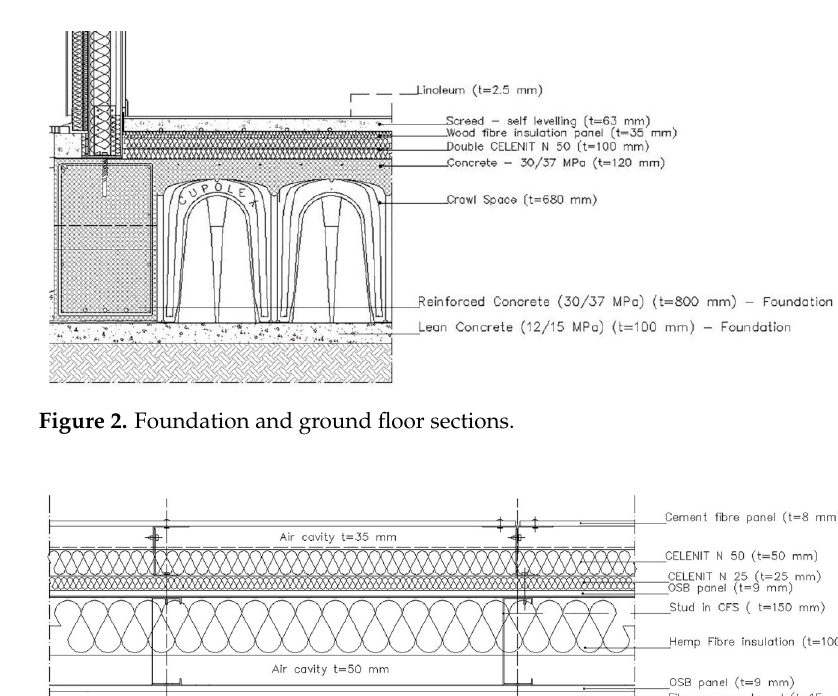
Figure 2. Foundation and ground floor